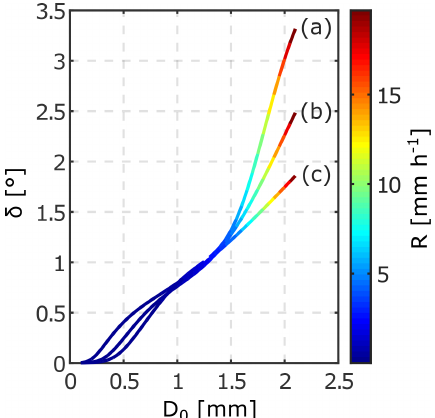
Figure 4. Simulated relations between the backscattering differen- tial phase δ and the median drop diameter D 0 at 94 GHz. The curves show simulations for DSDs, with N L = 2500mm − 1 m − 3 and µ equal to 5 (a) , 0 (b) , and 15 (c) . The corresponding rain rate R is color coded; the maximum rain rate for all simulations is limited to values smaller than 20mmh − 1 . The calculations are made for a 20 ◦ C and 30 ◦ elevation